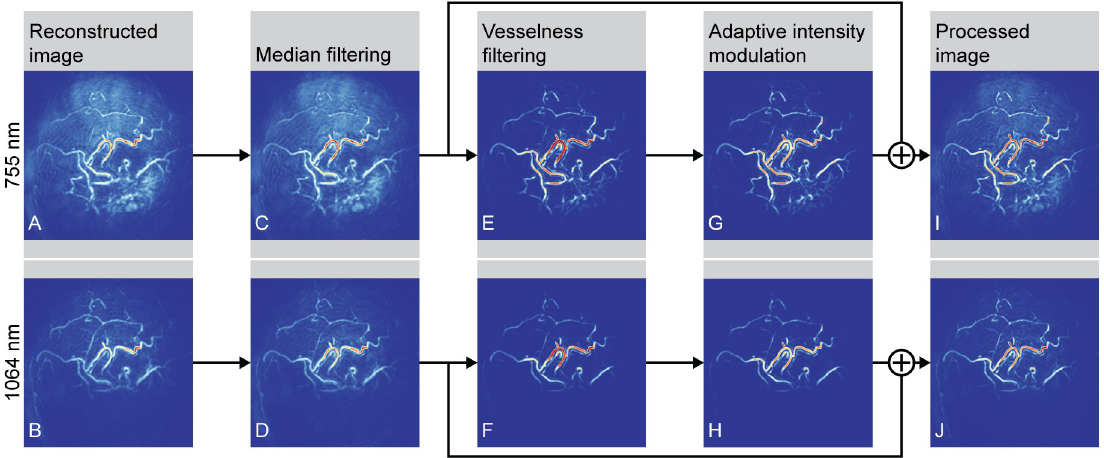
Fig 2. Processing pipeline. Coronal view maximum intensity projections of case 1 are shown, to illustrate the different processing steps. Top row shows images obtained by illuminating the left breast of the patient with 755 nm, bottom row shows the same breast illuminated with 1064